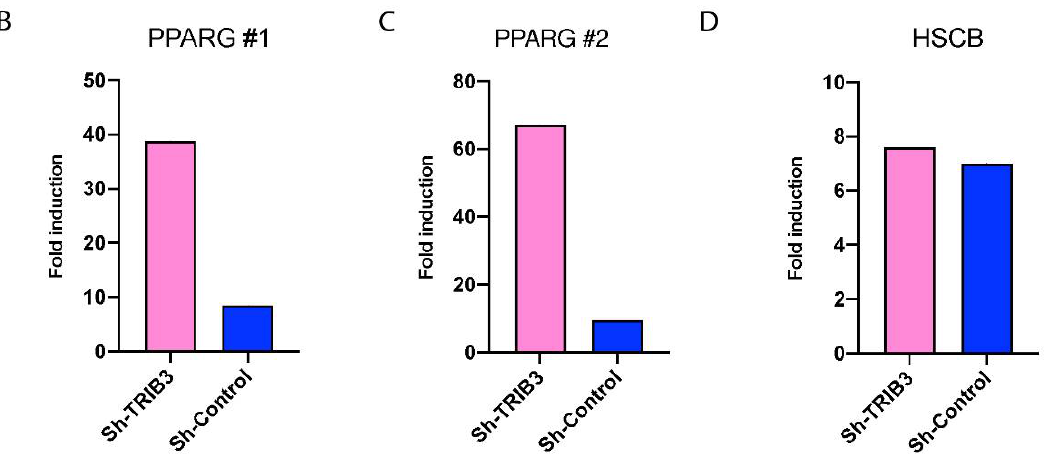
Figure 5. TRIB3 expression influences H3K4me 3 mark in the PPARG locus in MCF7 cells. ( A ) ChIP-seq data of WDR5 (GSM1493030), RBBP5 (GSM1037511), KMT2A (GSM2373702), KMT2D (GSM3444924) and H3K4me 3 (GSM3444908) in HEK293T cells as well as KMT2C (GSM3414777) and H3K4me 3 (GSM2813049) in MCF7 cells with 7 kilo-bases around PPARG locus shown. ( B ) ChIP-RT-qPCR of H3K4me 3 in Sh-TRIB3 and Sh-control cells in MCF7 using 2 different sets of primer pairs ( B , C ) designed around the PPARG transcription start site (TSS) shown in A. ( D ) ChIP-RT-qPCR of H3K4me 3 around TSS of HSCB gene.